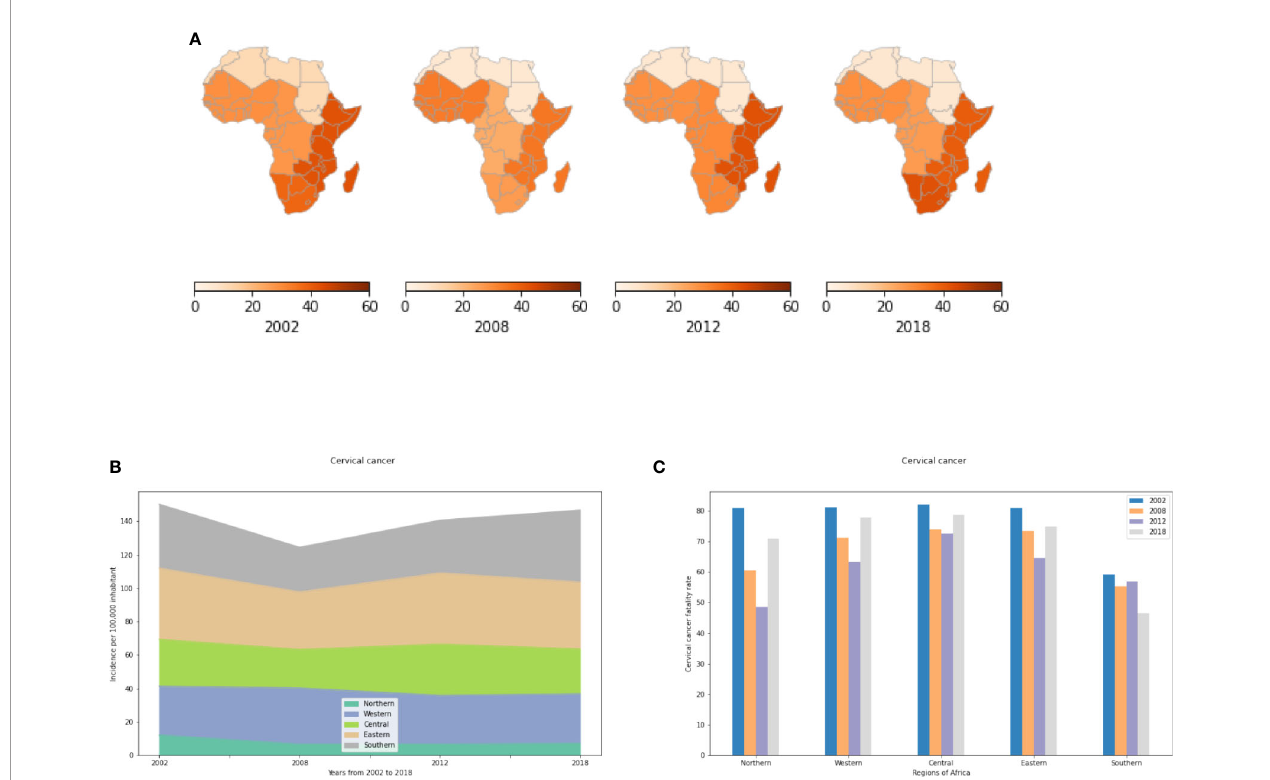
FIGURE 3 | Cervical cancer incidence and fatality rates in the different African regions. (A) Incidence of cervical cancer per 100,000 inhabitant by African regions. (B) Evolution of Incidence rates from 2002 to 2018. (C) Fatality rates (percent mortality per year of those af fl icted) of cervical